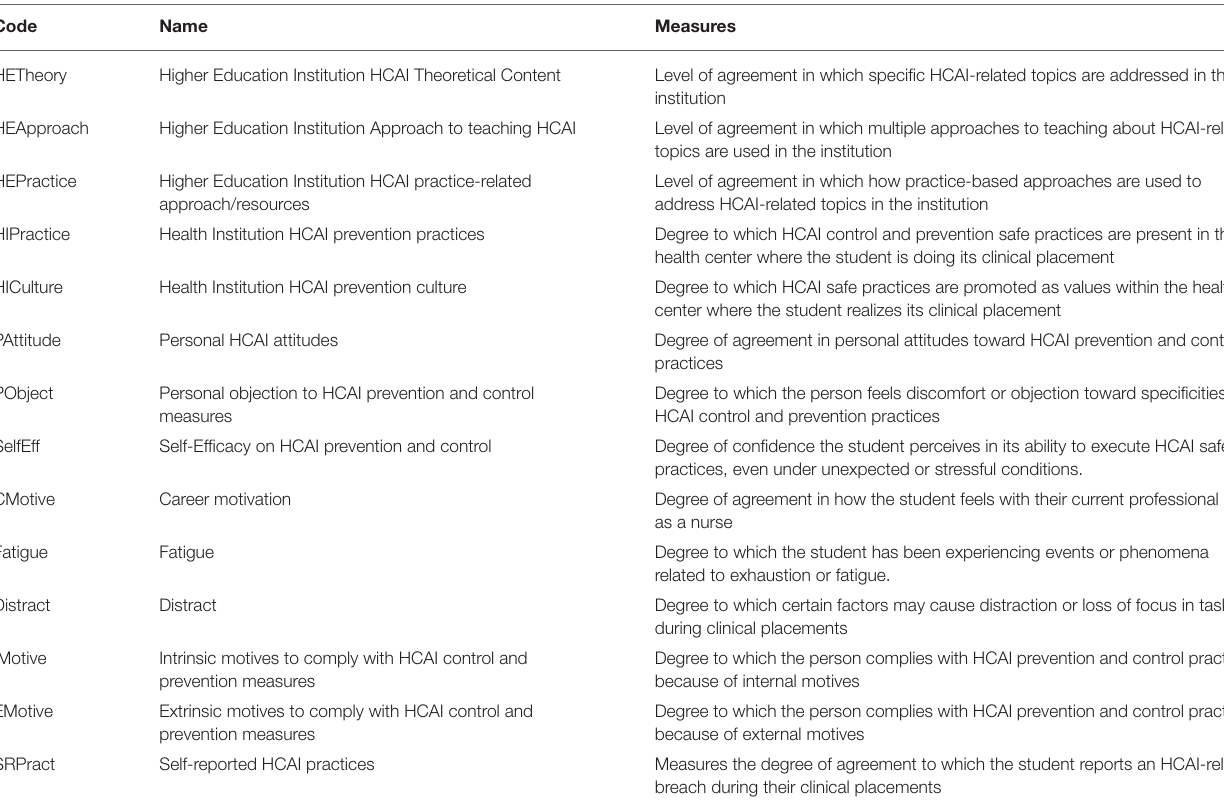
TABLE 1 | InovSafeCare